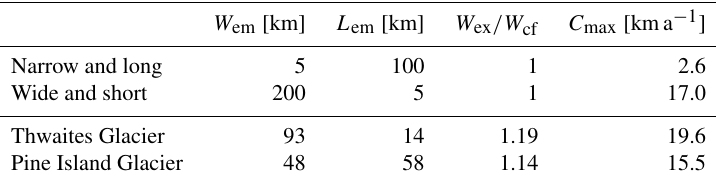
Table 1. Upper bounds on calving rates given by Eq. (1) with µ 0 = 0 . 3, γ = 0 . 2 and u ex = 100kma − 1 . We first consider two extremes of a narrow and long as well as a wide and short buttressing mélange, while assuming a rectangular mélange geometry with constant mélange width, W ex = W cf = W em . For Thwaites and Pine Island Glaciers, we assume mélange geometry similar to the current ice shelf. The smaller the upper bound C max , the stronger the buttressing effect caused by the ice